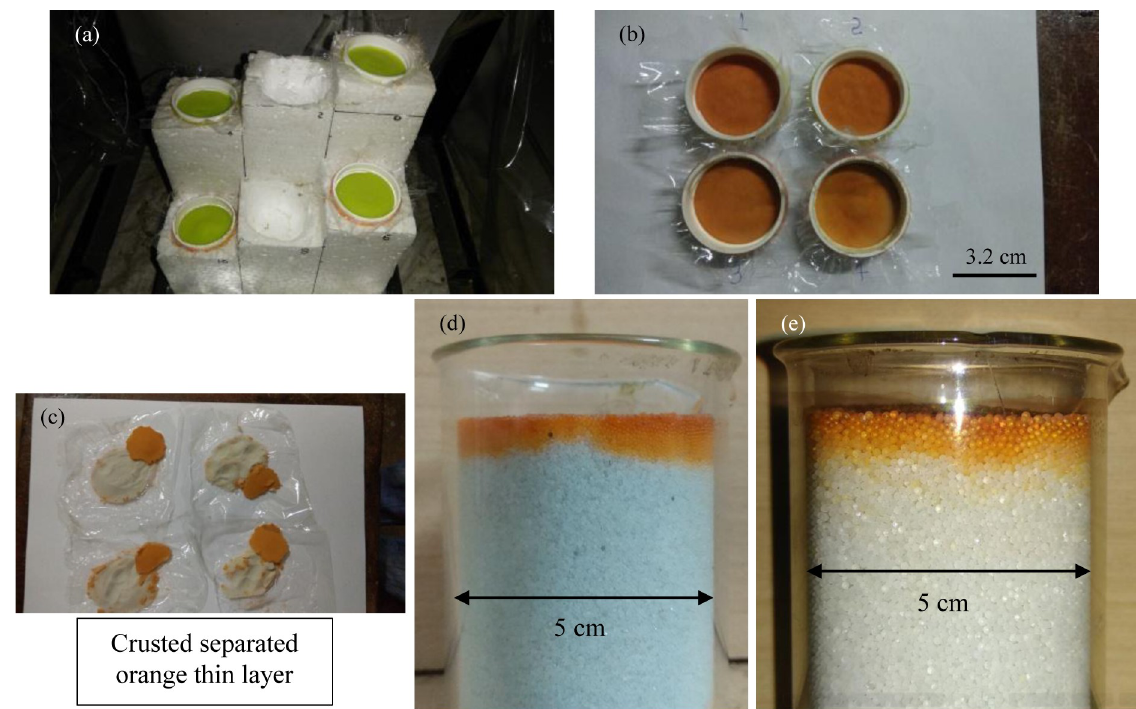
Fig 8. Snapshots showing the condition of samples of crusts for different incident heat fluxes. Different (hydrophilic) glass bead sizes were used for this study as well. The initial setup in (a) ensures different heating loads, for the four small containers (consisting of DI water, fluorescein dye, and 0.13 mm diameter hydrophilic glass beads), as the distances from its surface to the IR heater was different. Image (b) showing the conditions at the end of the experiment. The image (c) shows the removed hardened upper crusted layers for the different heat load experiments. The end conditions are seen for hydrophilic 0.45 mm diameter glass beads (d) and 0.78 mm diameter glass beads (e).